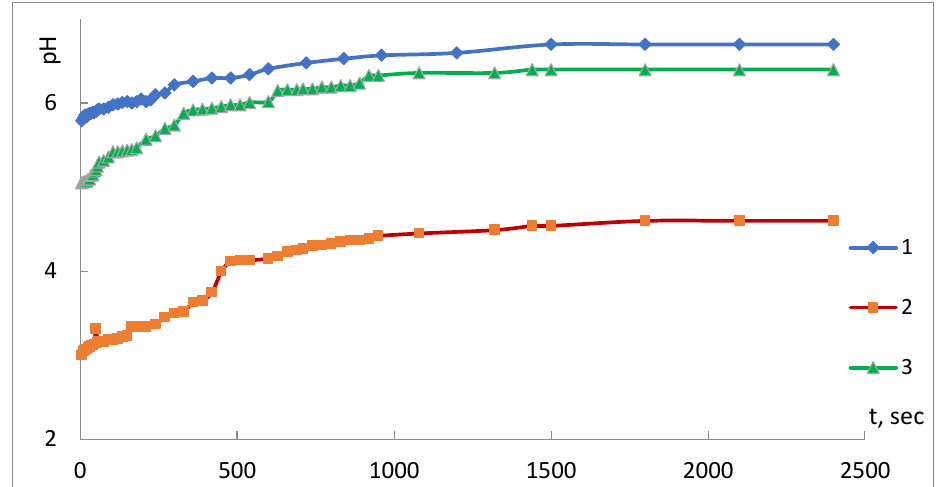
Figure 3. Kinetic curves of pH variation in aqueous suspensions of the PP fiber: ( 1 )—raw; ( 2 )—modified by Fe 0 using the SHF method; ( 3 )—modified by Fe 0 using the II method.